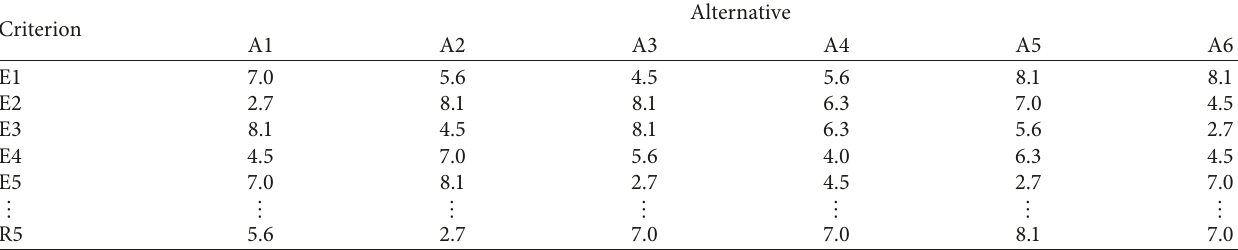
Table 11: Performance data of the six alternative partners (final scores).